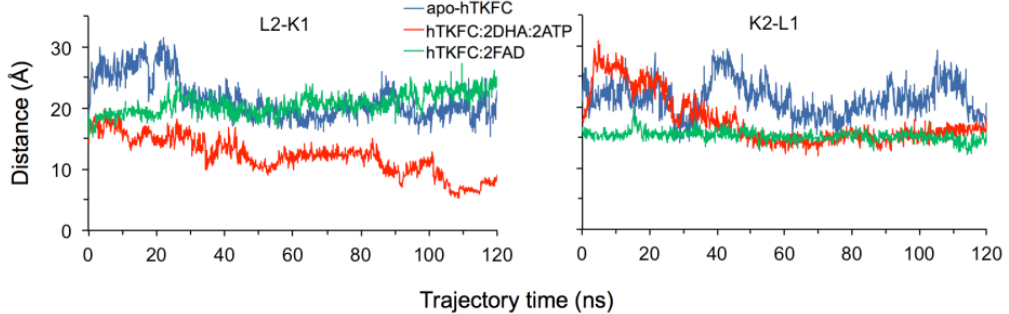
Figure 11. Estimation of the closure of the active sites of hTKFC and its complexes with kinase or cyclase substrates during the simulated trajectories. Distances were measured between Mg2 in the L domain and the N ε 2 of His 221 in the K domain of the same site, i.e., L2-K1 or K2-L1. Once it was established that ATP and DHA bound to hTKFC favored at least the closure of one of the active sites, we scanned the 160-ns trajectory of hTKFC:2DHA:2ATP for the two parameters which delimit the possibility of in-line nucleophilic attack of DHA (the trihydroxyprop-2-yl radical covalently bound to His 221 ) over the γ -phosphorus of ATP: O ··· P distance and O ··· P–O angle. Since the two hydroxyl groups of DHA (and of the trihydroxyprop-2-yl radical) are equivalent, two O ··· P pairs were considered in each active site.